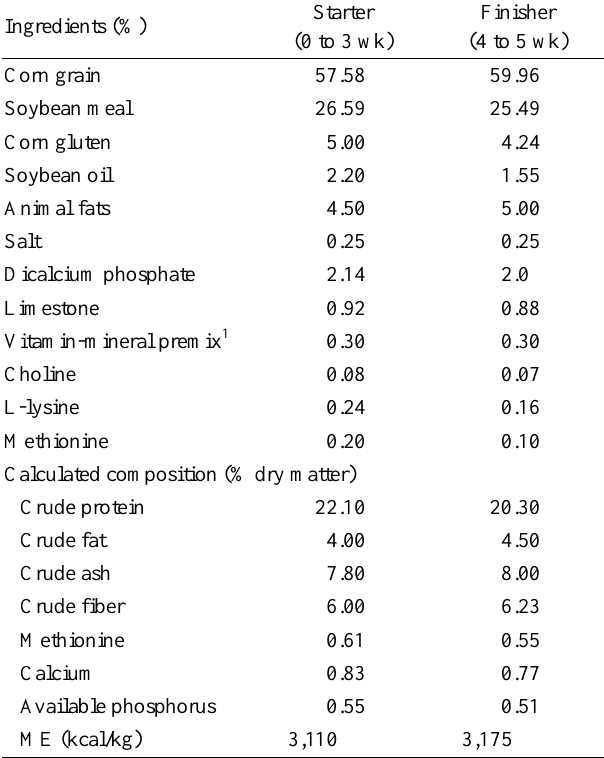
Table 2. Feed ingredients and chemical compositions of the broiler basal diets Ingredients (%)